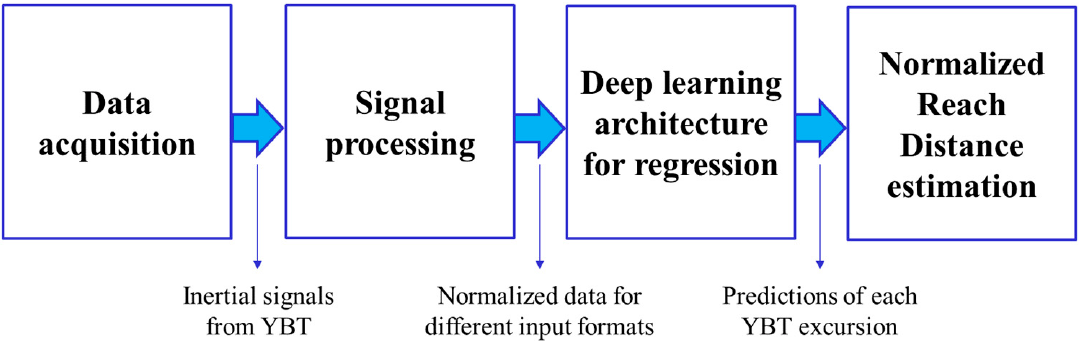
Figure 5. HAR framework of this work including the outputs of the intermediate modules.